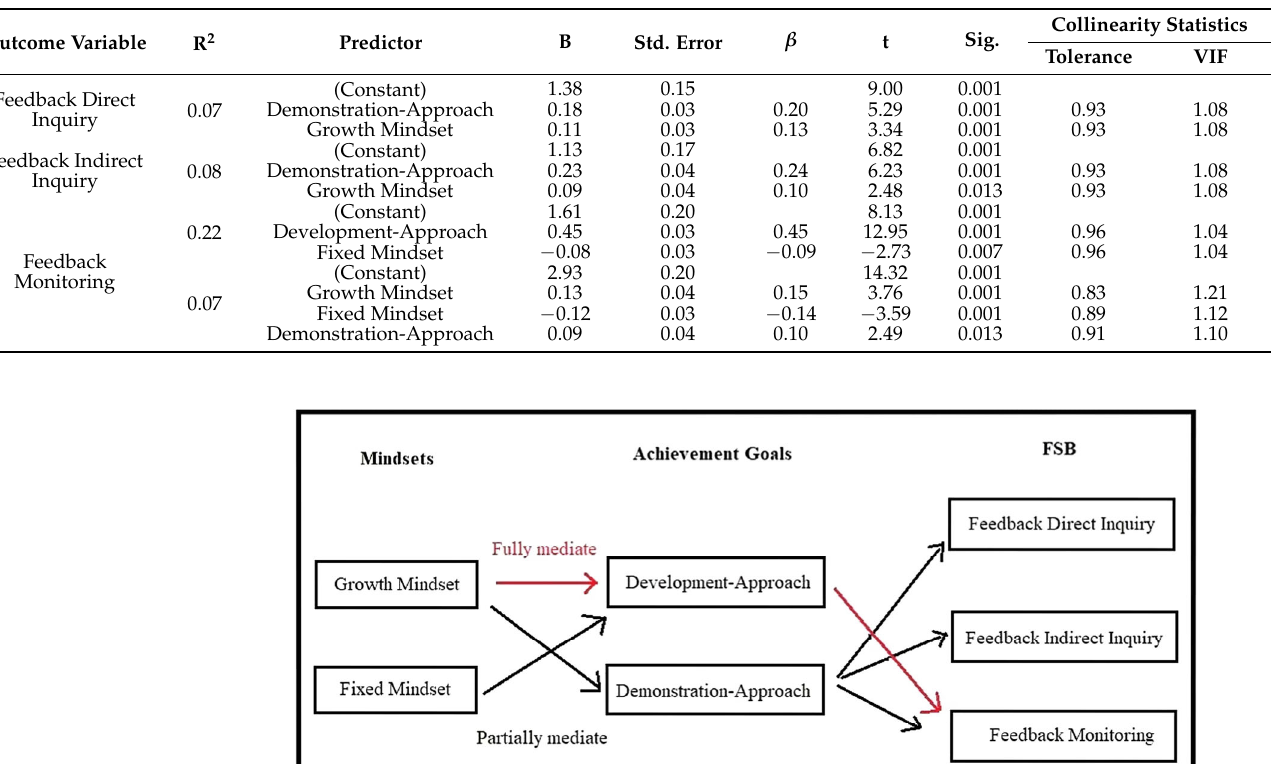
Table 6. Mediating Role of Achievement Goals on Relationships Between Mindset and FSB.